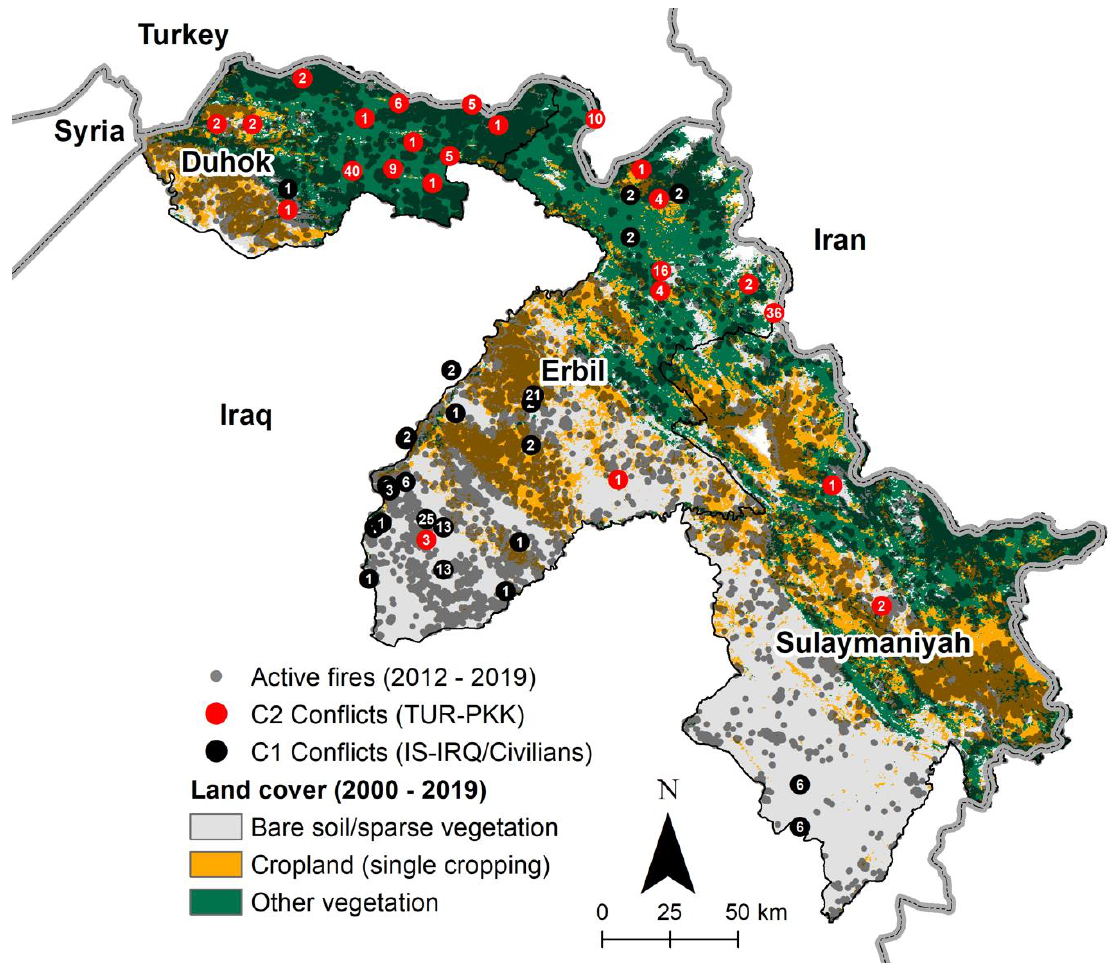
Figure 3. Changes in average LULC extent between the baseline periods and the conflict periods. Labels with percentages indicate the areal change from the long baseline period (B1) to the corre- sponding conflict period (C1 or C2). The error bars denote the standard error of each change.